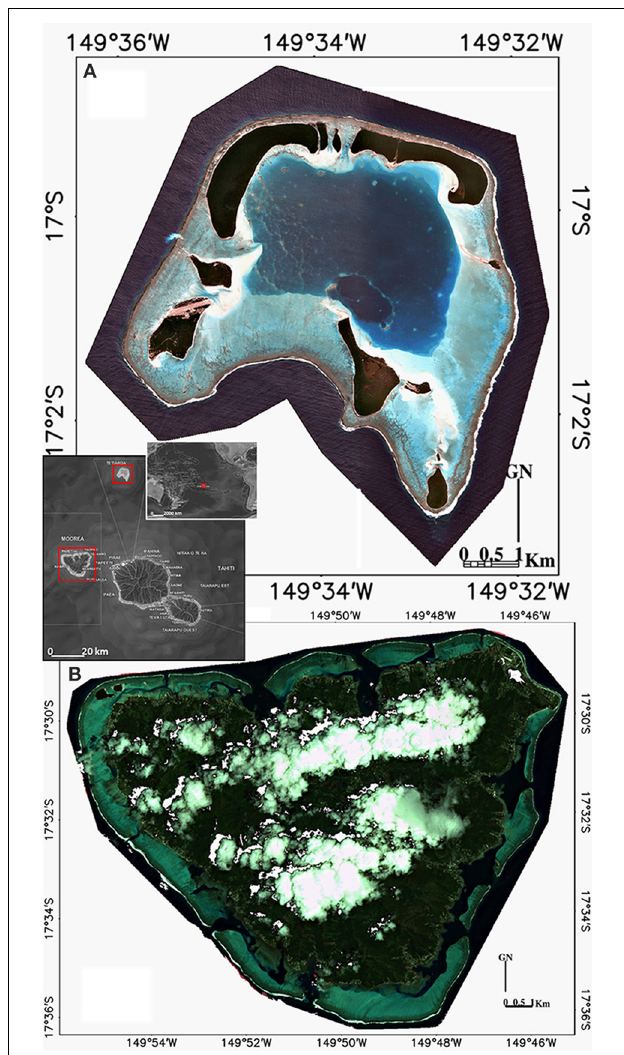
FIGURE 1 | Location and true color composite images (RGB:532) of the two islands composing our study area in the Archipelago of the Society Islands, French Polynesia: (A) Tetiaroa atoll and (B) Moorea volcanic